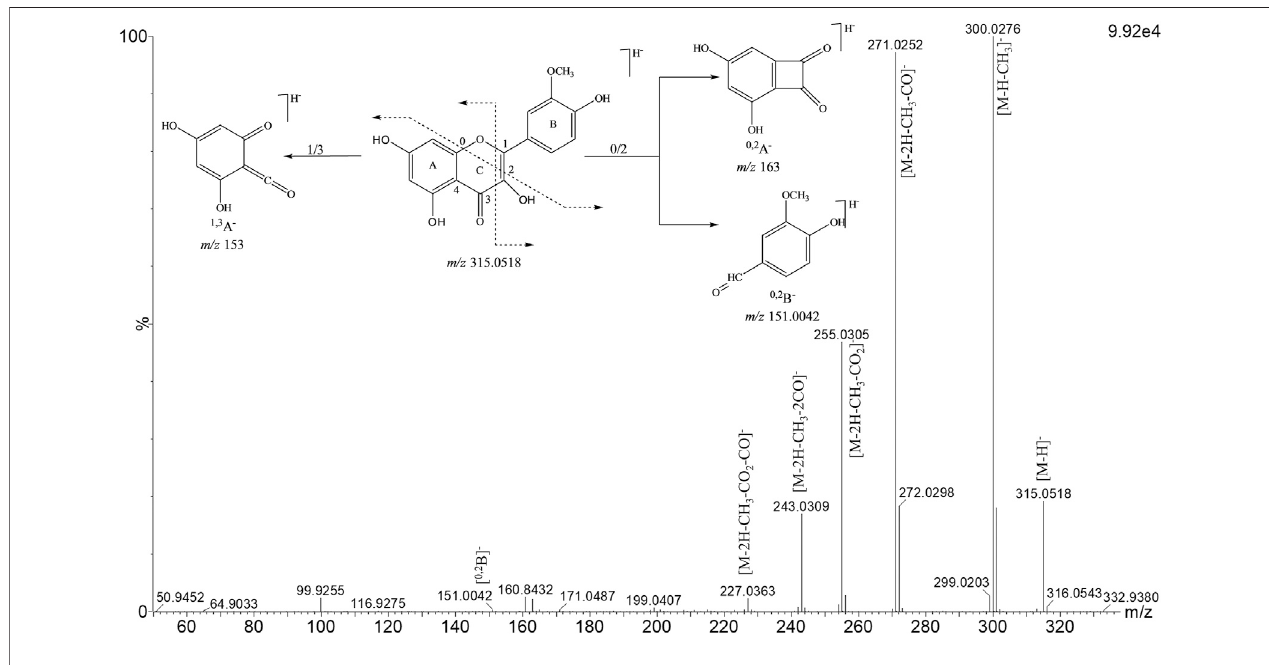
FIGURE 2 | Product ion spectrum of fl avonoid 8 (Isorhamnetin).